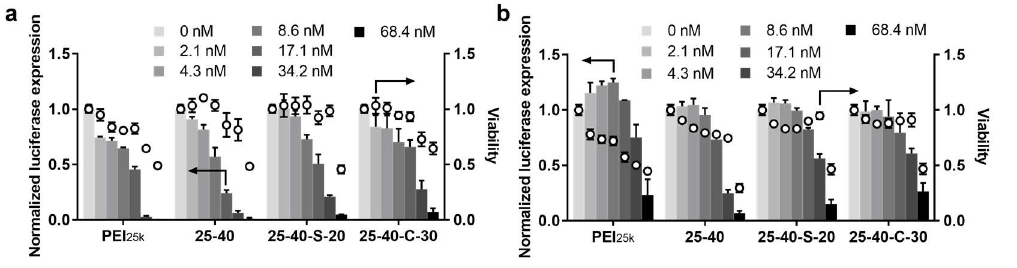
Figure 3. siRNA dose response for the top performing carriers. ( a ) HeLa-Luc and ( b ) A549-Luc. (mean ± SD, n = 3).